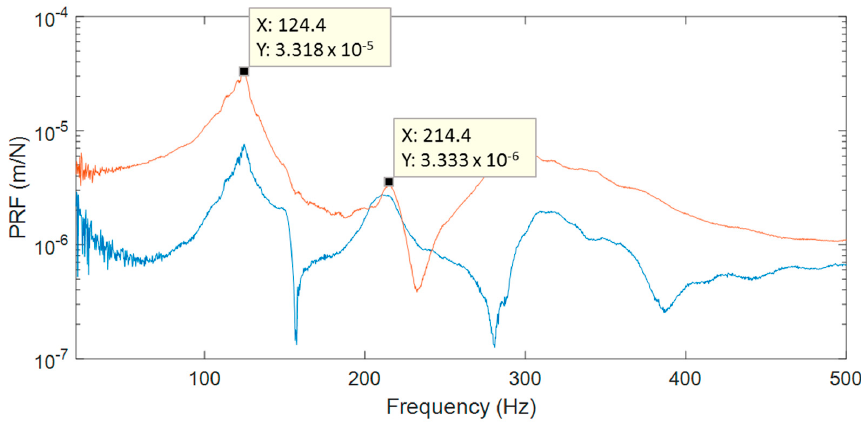
Figure 6. Two principal response functions from impact hammer tests of specimen 1.